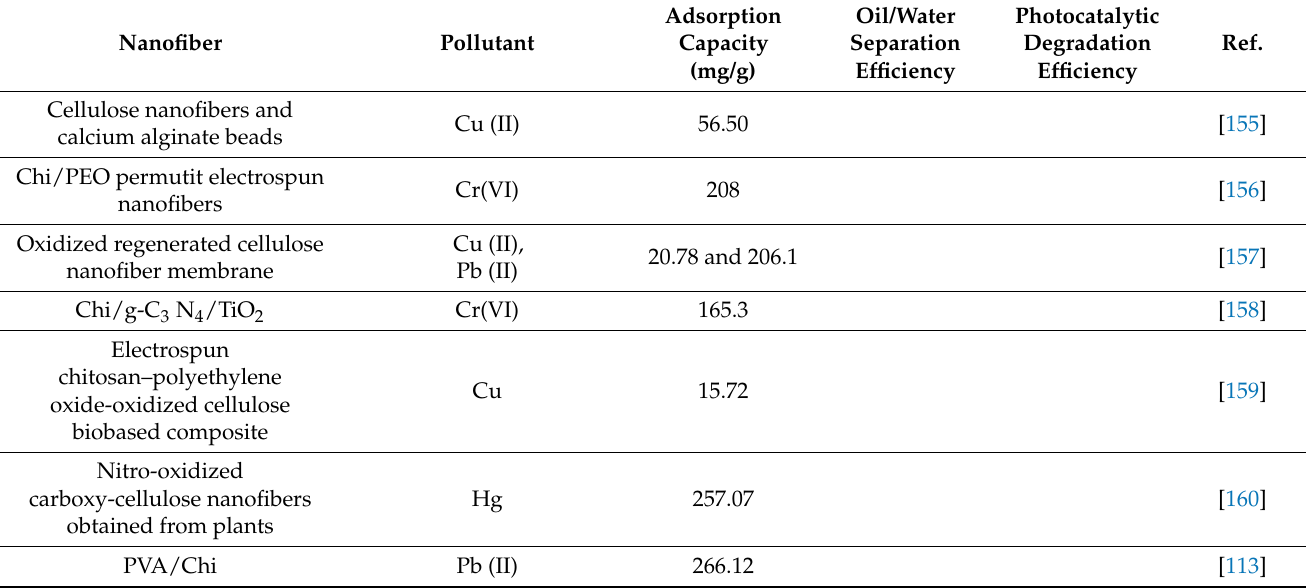
Table 4. Some of recent fabricated sustainable nanofibers (eco-friendly) used in water purification processes.